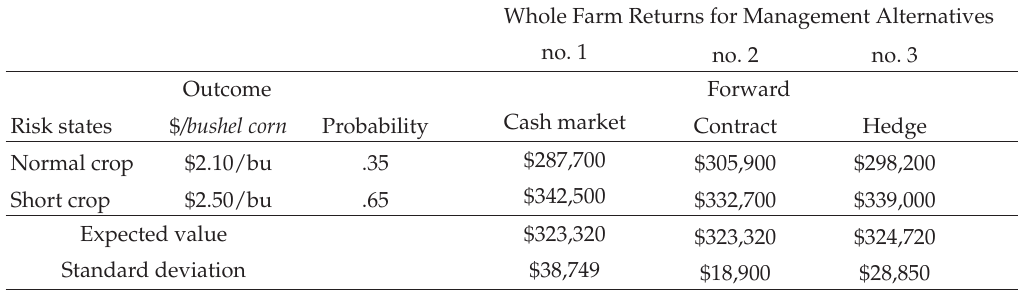
Table 2: Payo ff matrix for EWS farms’ corn pricing decision; see source in (cid:4) 6 (cid:5)